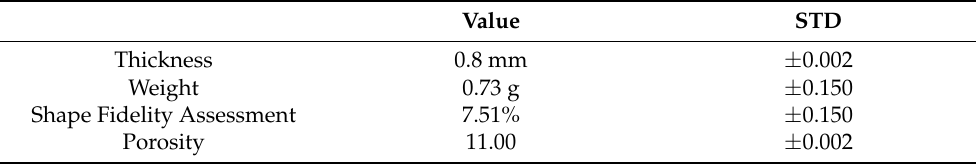
Table 3. Average thickness, weight, variation of the expected shape and porosity of the 3D-printed films. Value STD